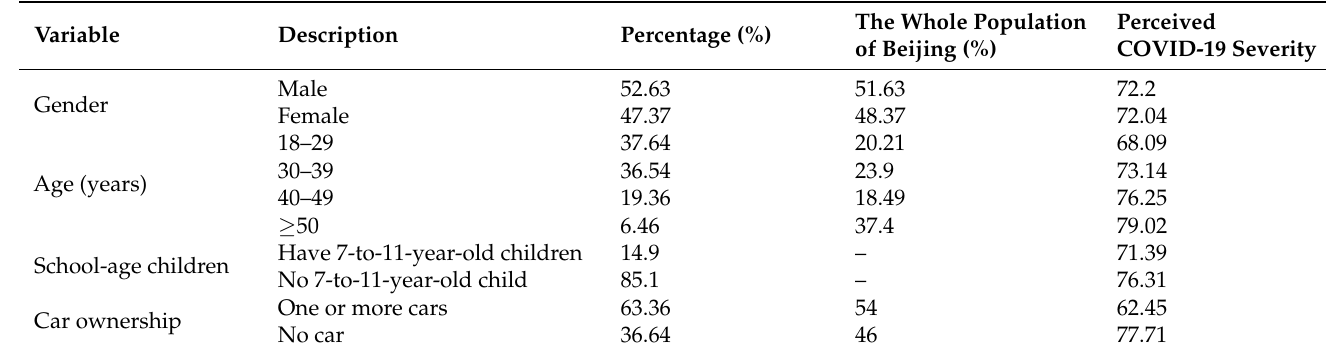
Table 2. Statistics of participants and their perceived severity of the pandemic.